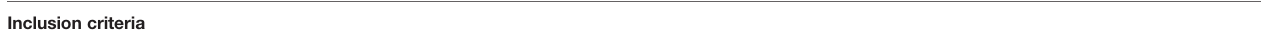
TABLE 1 | The key inclusion and exclusion criteria of this study. Inclusion criteria 1. Patients with incurable metastatic or unresectable prostate cancer, which was con fi rmed by histopathology and/or cytology (including postoperative recurrence and metastasis) without neuroendocrine differentiation or small cell features. 2. Patients who failed ADT therapy combined with at least one novel endocrine therapy (including enzalutamide, abiraterone, apalutamide, and so on, while not including bicalutamide and fl utamide) or failed ADT therapy followed by at least one novel endocrine therapy. 3. Patients with hormone-sensitive prostate cancer (HSPC) who had not received ADT therapy combined with a docetaxel regimen, or patients who required or were unable to tolerate or refused docetaxel regimen chemotherapy after diagnosis of CRPC. 4. Patients with mCRPC with DNA-HRR gene mutation who had not received PARP inhibitor therapy, who had refused PARP inhibitor therapy, or had a